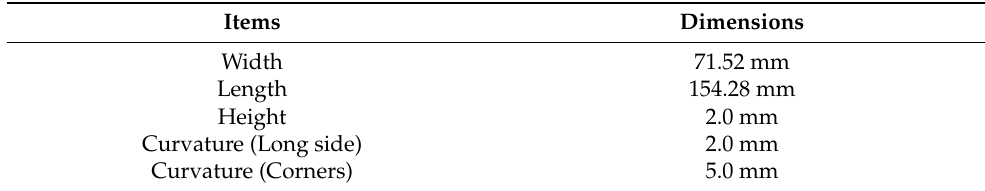
Table 2. The physical dimensions of a latest smart